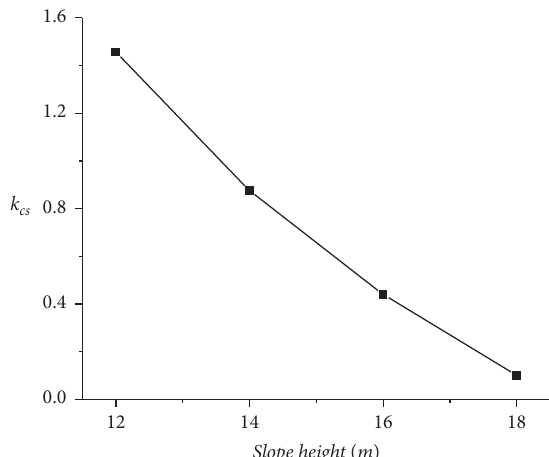
Figure 16: Variation in the yield acceleration coefficient with slope height.